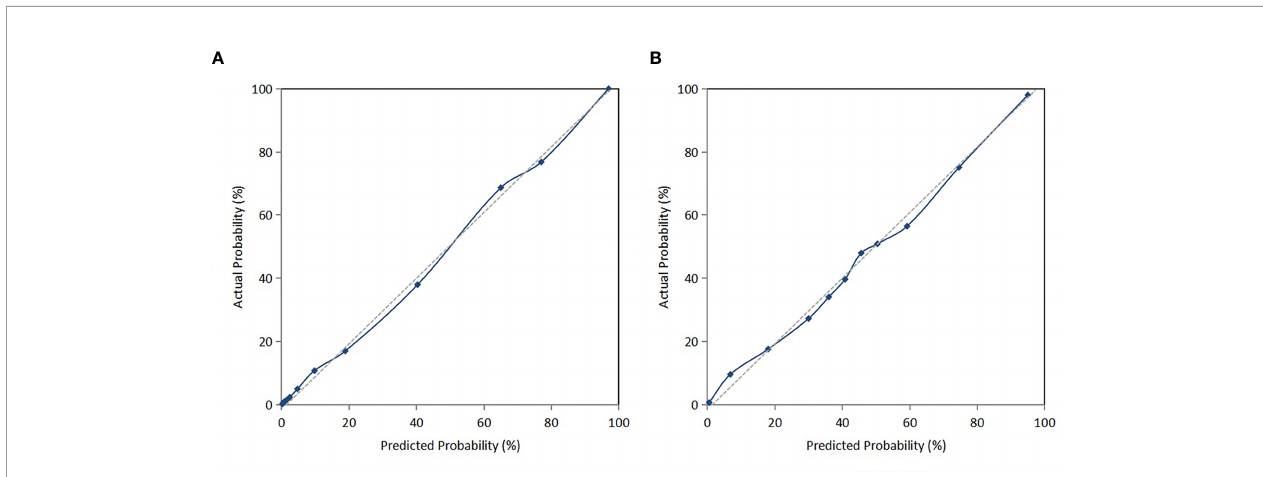
FIGURE 3 | (A) Calibration curve of the nomogram in the development cohort. (B) Calibration curve of the nomogram in the validation cohort.